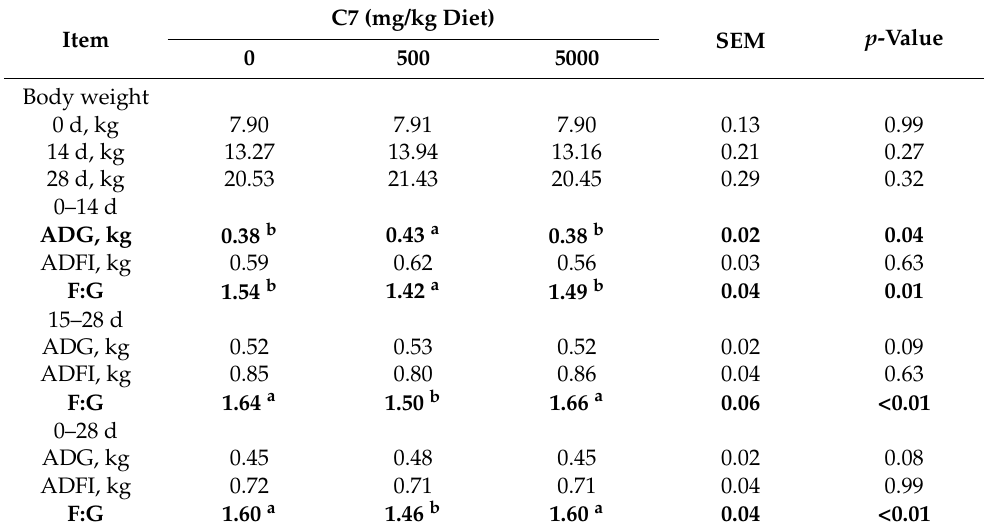
Table 5. Effects of high-dose C7 supplementation on growth performance of weaned